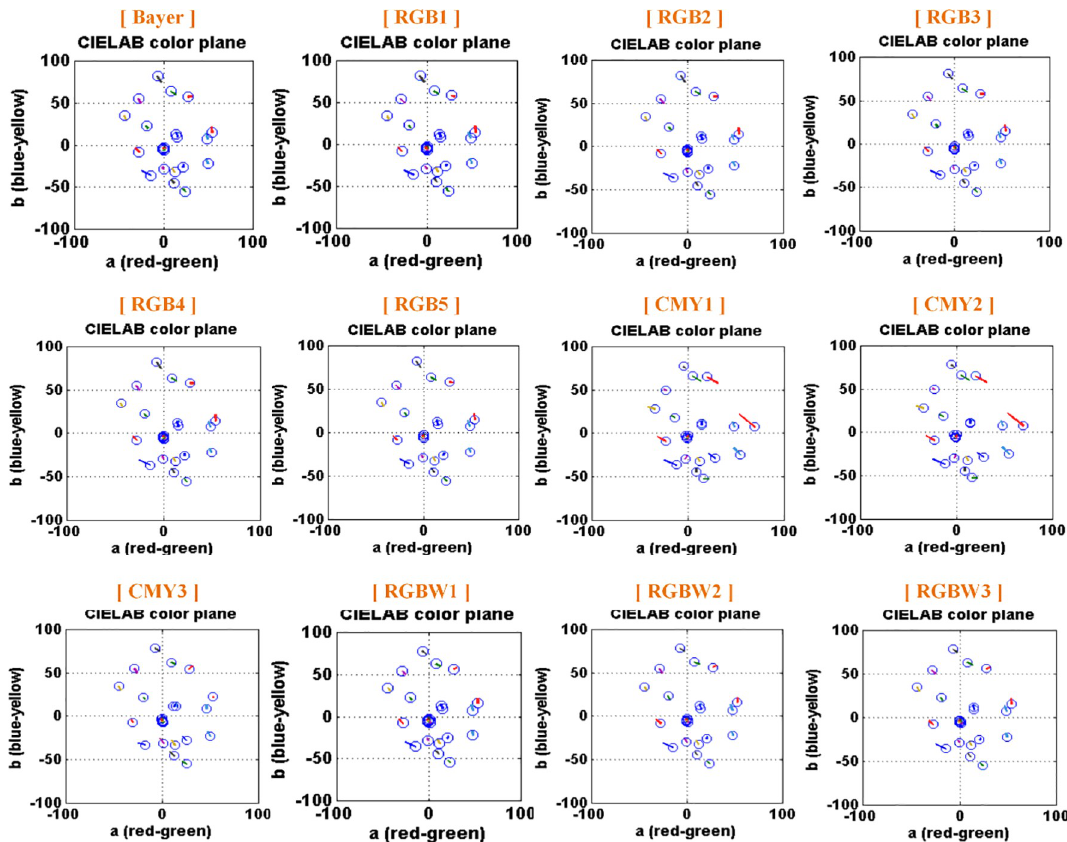
Fig 8. Color difference error of 24 color patches for test CFAs.